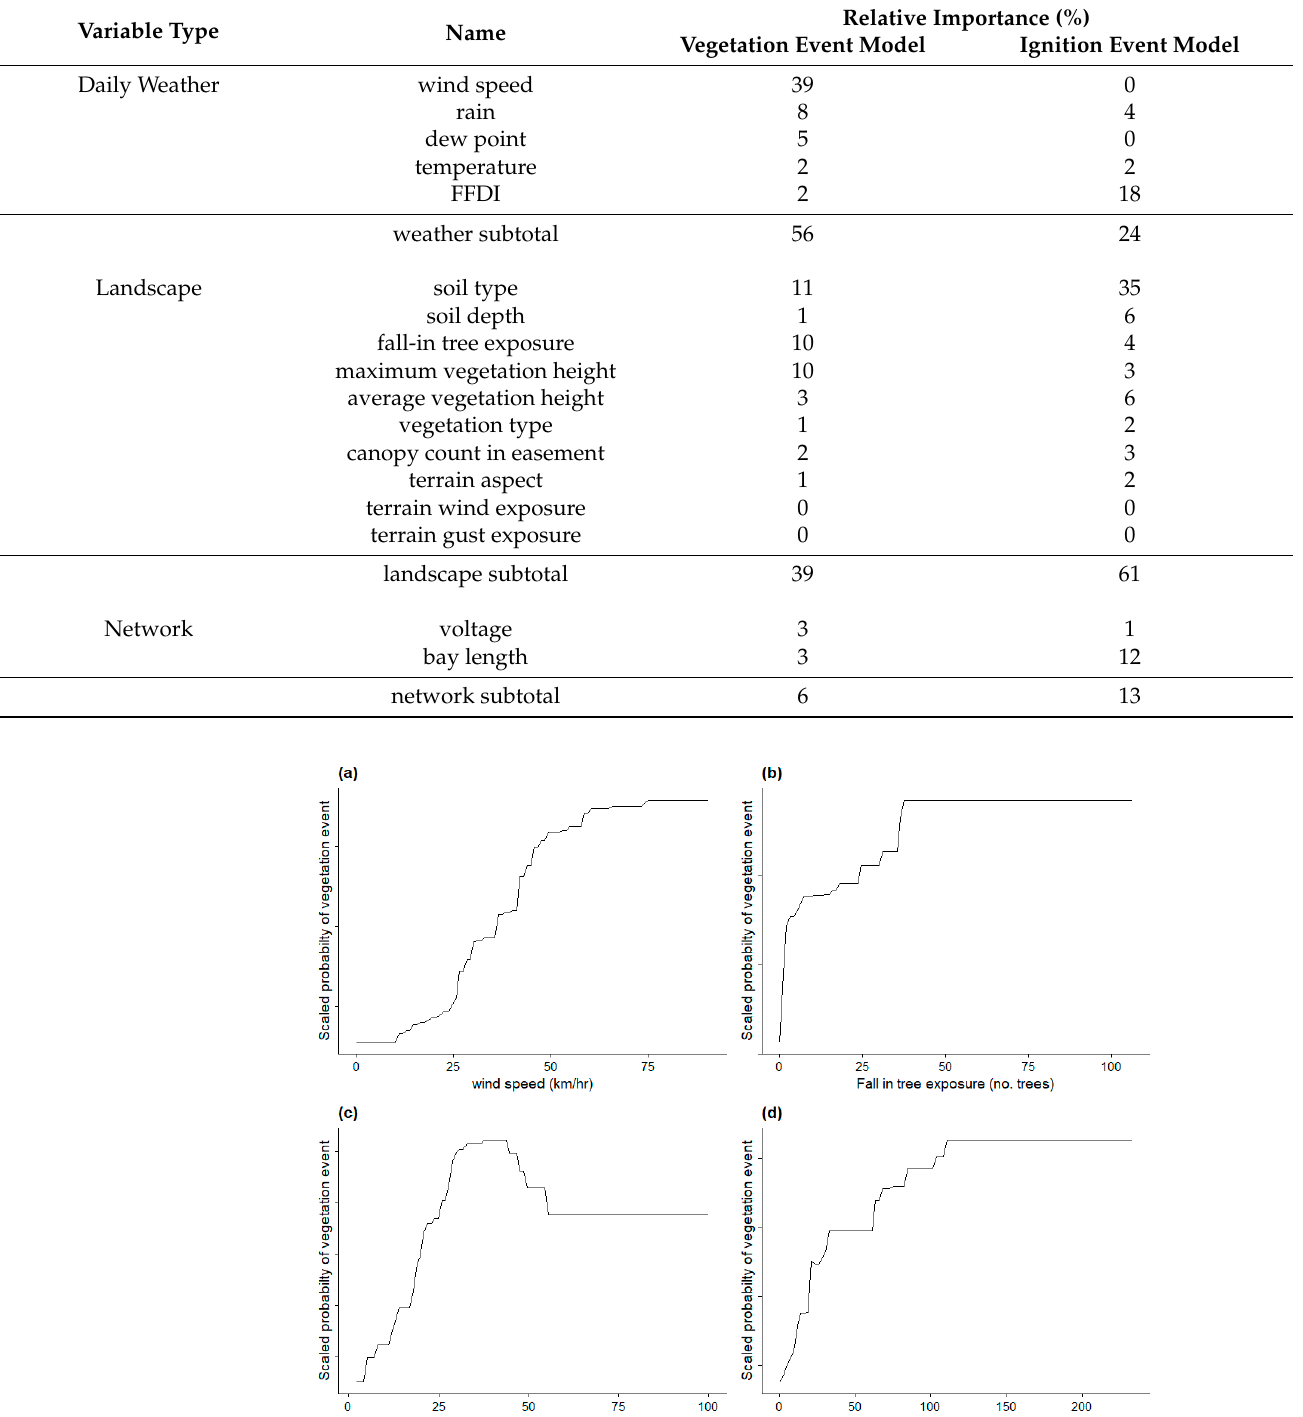
Table 3. Relative importance of input variables in the vegetation and ignition event models.